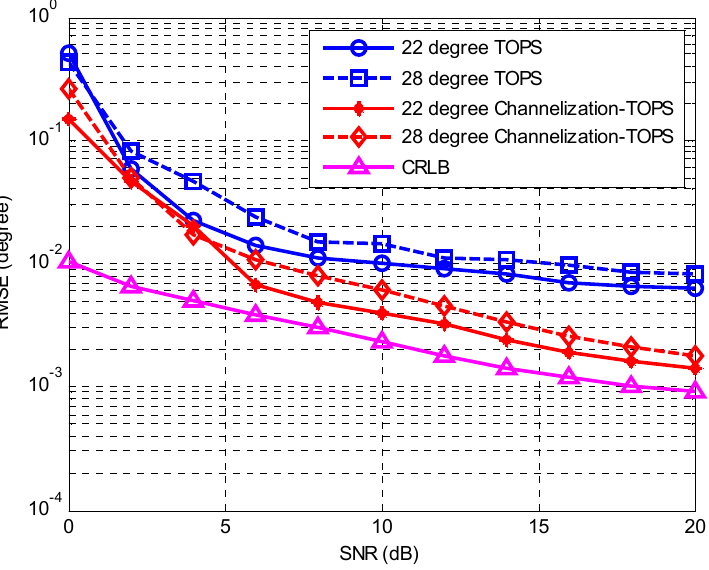
Figure 5. RMSE of the DOA estimates against the SNR.